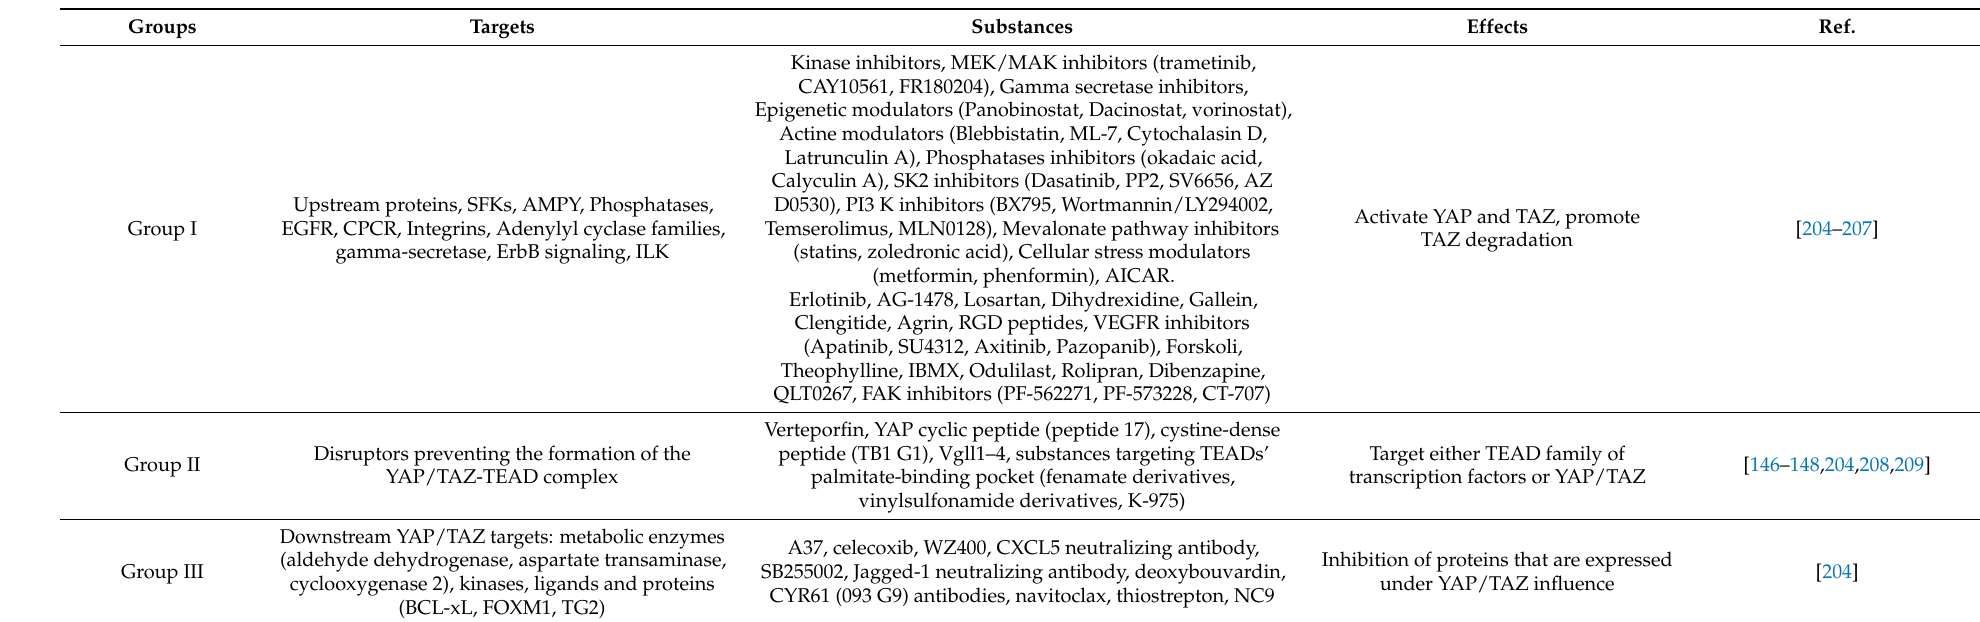
Table 2. YAP/TAZ-inhibiting